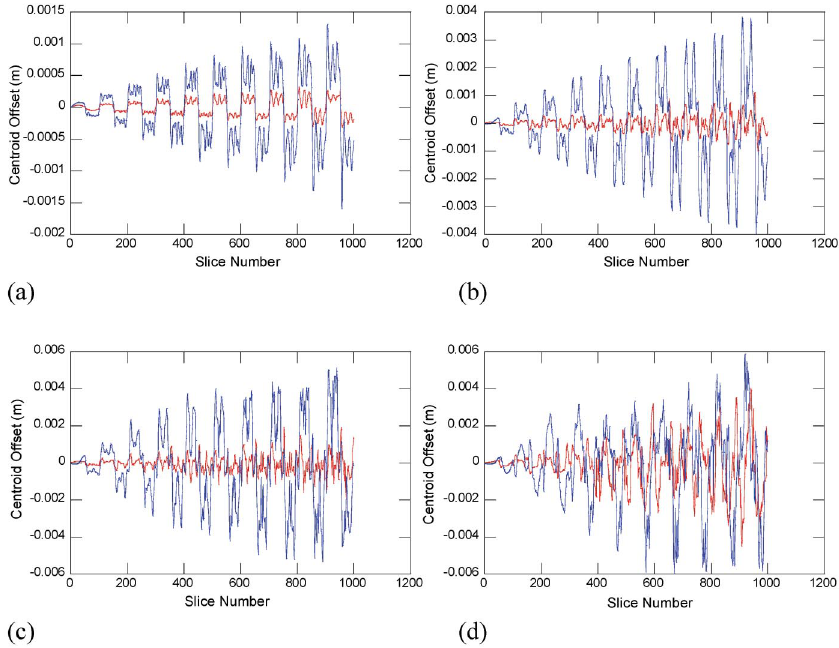
FIG. 34. (Color) Electron centroids at (a) 2.5 m, (b) 5 m, (c) 7.5 m, and (d) 10 m for a 2 msec beam in the downstream transport, for an initial offset period of 200 nsec. The red line is for the horizontal offset and the blue line is for the vertical